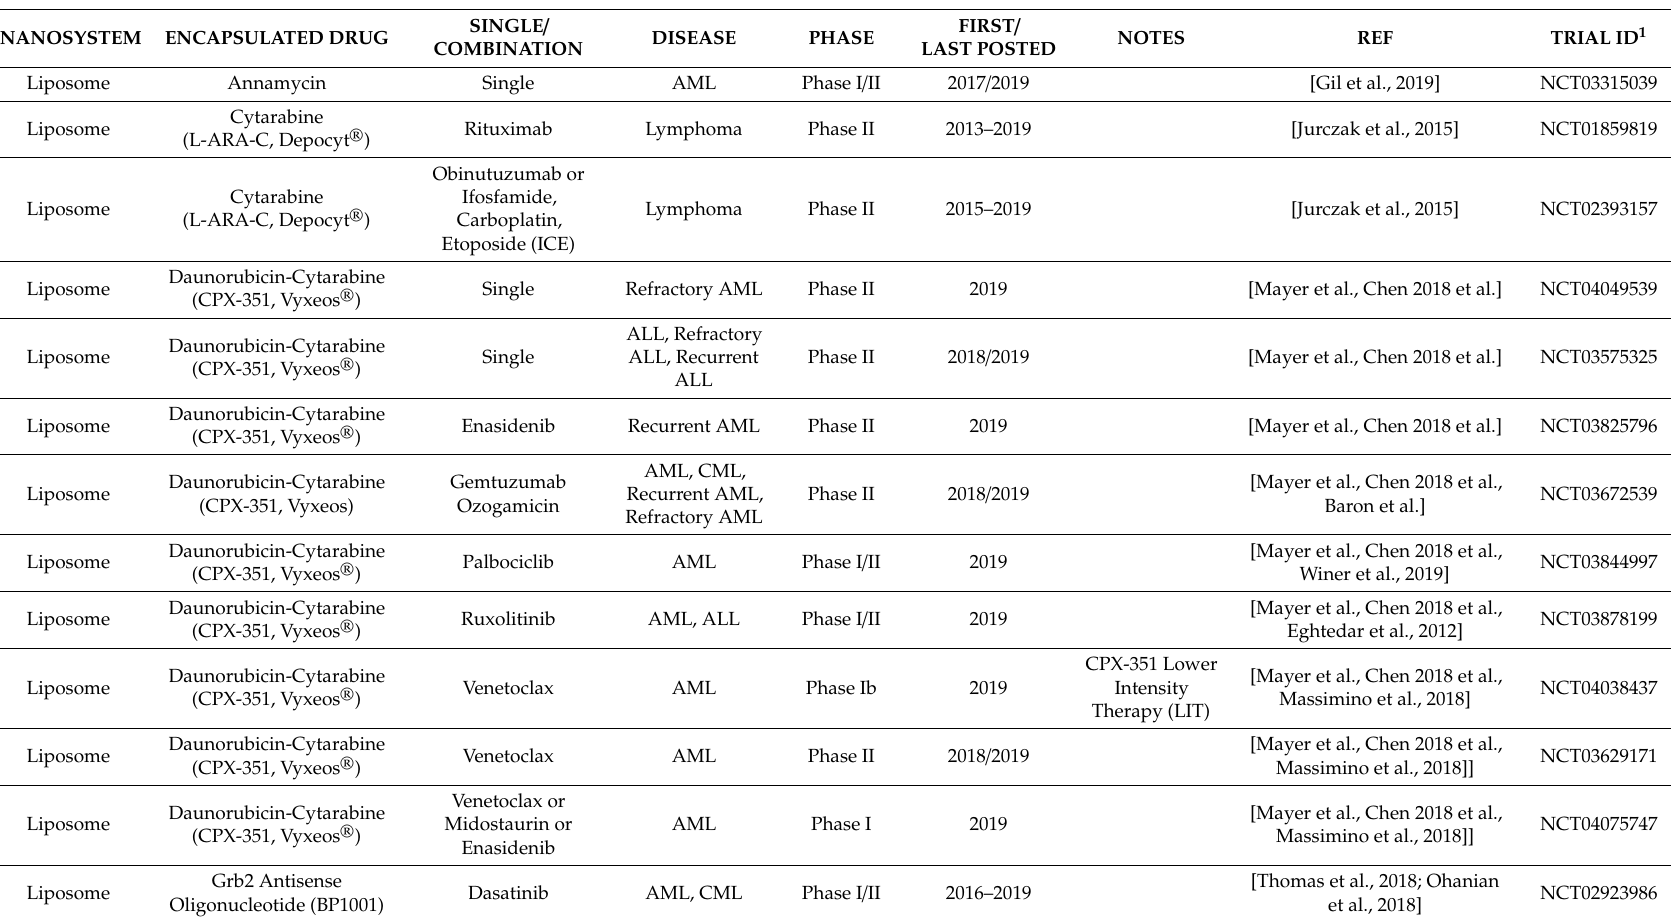
Table 2. Ongoing clinical trials involving nanosized systems administered alone or in combination with other drugs or biological agents for the treatment of various myeloid and lymphoid malignancies. 1 Trial ID refers to Clinicaltrials.gov